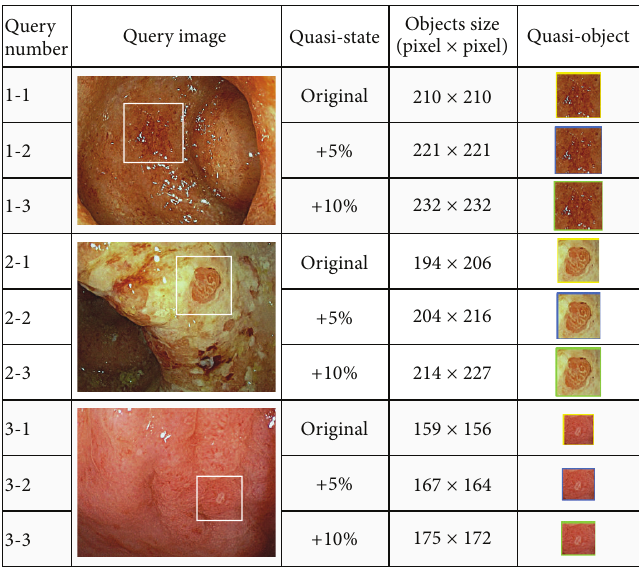
Figure 11: Query quasi-objects for three colonoscopy